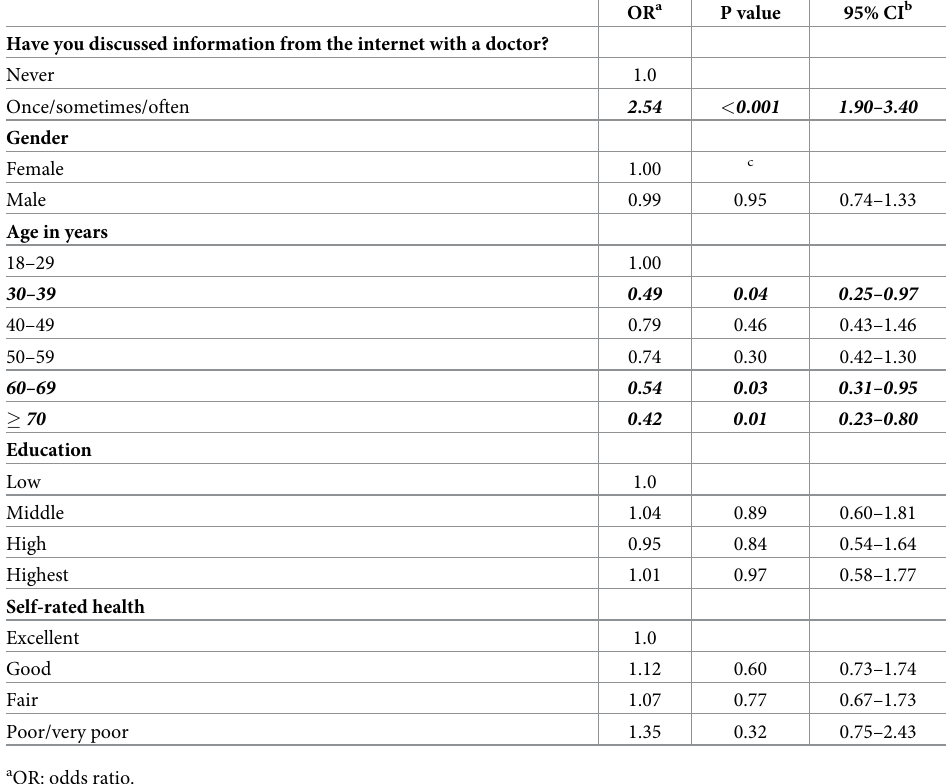
OR a P value 95% CI b